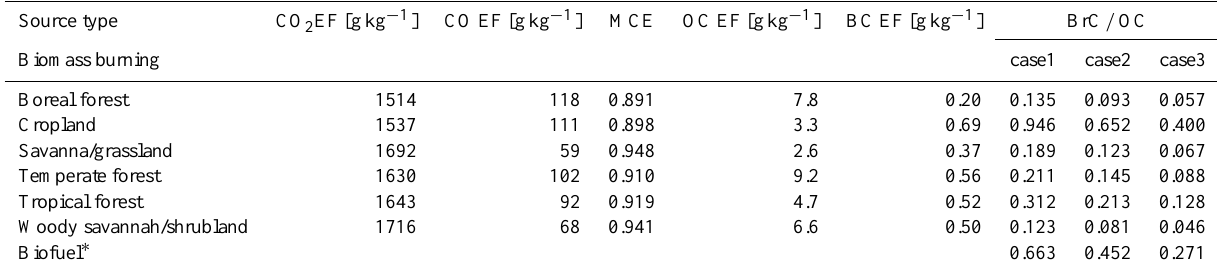
Table 1. Emission factors (EFs) and calculated parameters used for primary BrC emission estimates. Biomass burning emission is classified for six vegetation types based on the FINN inventory. Here BrC / OC is the mass ratio of BrC to OC emitted from biomass burning and biofuel